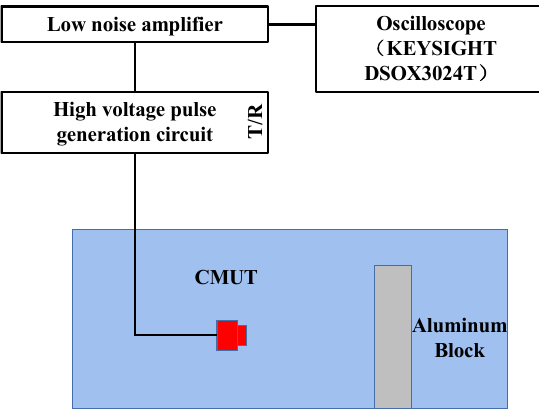
Figure 13. Schematic diagram of pulse echo device test.